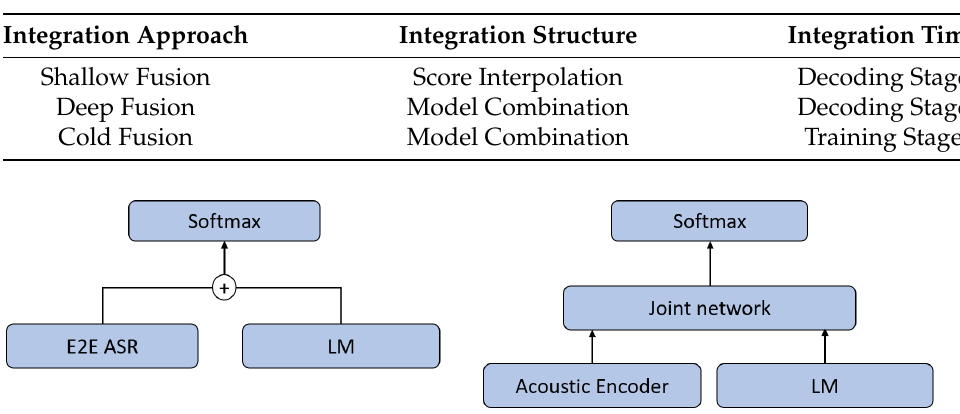
Table 1. LM integration approach comparison.